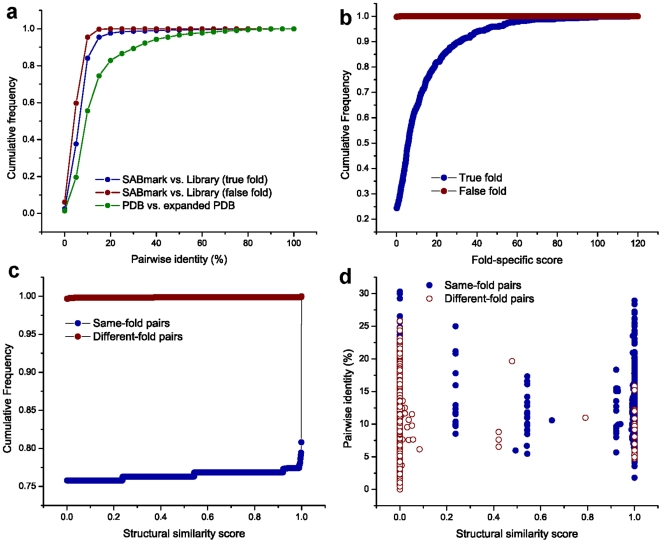
Characterization of Structural Similarity Scores.
(a) The distribution of percent pairwise identity between pairs of TZ-SABmark sequences and the library sequences of the same-fold (blue) and different-folds (red) and percent pairwise identity between the original PDB sequences and PSI-BLAST expanded sequences (green). All three comparisons demonstrate that nearly all of the sequence alignments reside in the “twilight-zone” of sequence similarity. The pairwise identity was calculated from Needleman-Wunsch global alignments] with BLOSUM62], Gap opening penalty 10, and Gap extension penalty 0.5. (b) The distributions of query sequence scores for each fold-specific library. (c) Cumulative frequencies of the structural similarity scores between pairs of same-fold (blue) and different-fold (red) query sequences. For this measurement, 3,428 same-fold pairs and 65,536 different-fold pairs were measured from 534 sequences. (d)
Structural similarity scores between pairs of same-fold and different-fold query sequences were plotted versus their pairwise sequence identity. This data shows an independent trend between the structural similarity score and pairwise identity in the “twilight-zone” of sequence similarity. For different-fold pairs, randomly selected 10,000 data points were plotted. The statistics in the Fig.S1 b, c, and d were obtained given the setting of e-value 0.01, no coverage threshold.